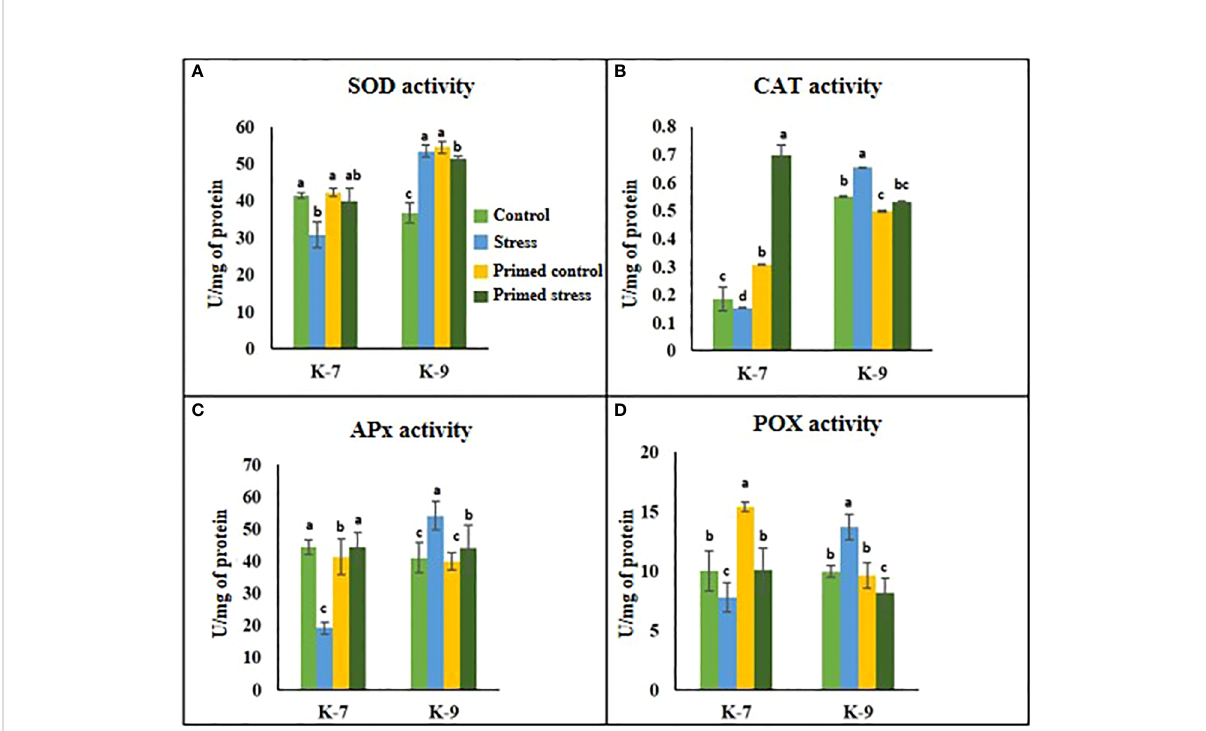
FIGURE 4 Effects of melatonin priming on antioxidant enzyme activities in drought-sensitive (K-7) and drought-tolerant (K-9) varieties with and without drought stress. (A) SOD activity; (B) CAT activity; (C) APx activity and (D) POX activity. Data represents mean values ± SD of 3 independent experiments. Different alphabets within the group represent signi fi cant differences among treatments according to Duncan ’ s multiple range test at P <